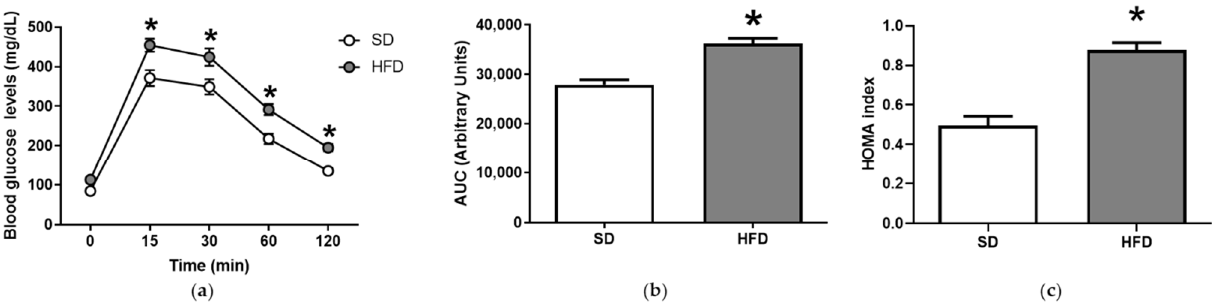
Figure A1. Mice fed an HFD exhibit impaired glucose homeostasis and insulin resistance. ( a ) Intraperitoneal glucose tolerance (IP-GTT) in mice fed an SD or HFD for 8 weeks. ( b ) Area under the curve (AUC) of the IP-GTT. ( c ) HOMA index. Data are the means ± SEM. N = 8 mice condition. * p < 0.05 vs. SD.